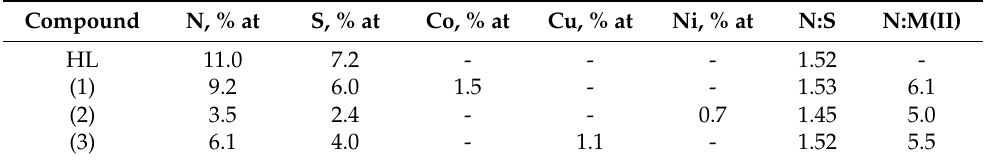
Table 4. Elemental composition of the investigated Schiff base (HL) and metal complexes (from EDS analysis). Compound N, % at